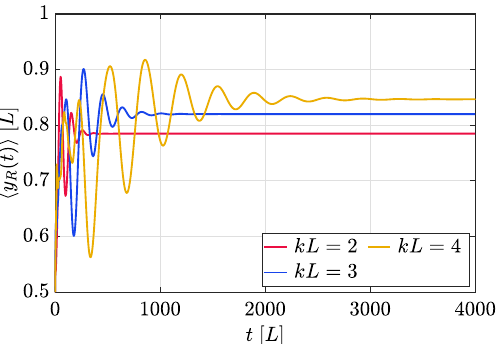
Figure 5. Expected value of the probability distribution along the extra dimension y , as calculated from the FPD, for different values of the warp coefficient kL . The initial condition is the same as in Fig.